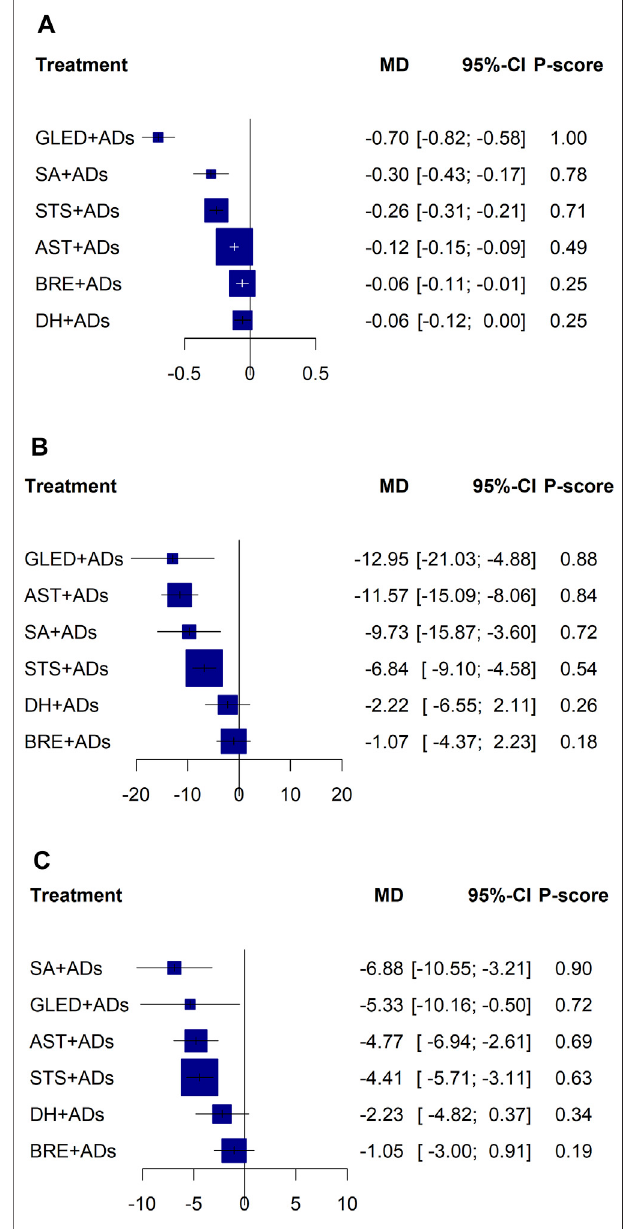
FIGURE 3 | Forest plots for primary outcomes. ADs: antihypertensive drugs; SA: salvianolate; DH: danhong; BRE: breviscapine; AST: astragalus; STS: sodium tanshinone IIA sulfonate; GLED: ginkgo leaf extract and dipyridamole. (A) : 24-h urinary protein excretion; (B) : Systolic blood pressure; (C) : Diastolic blood